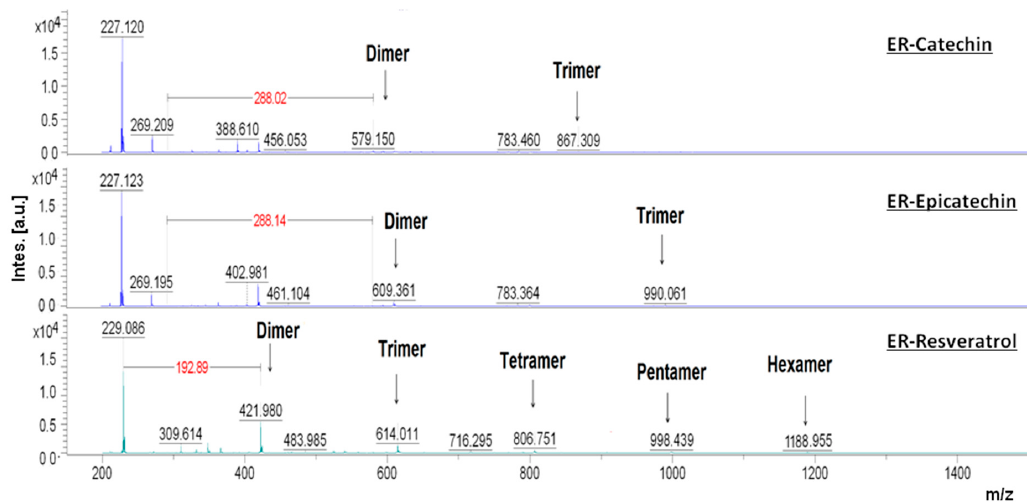
Figure 2. Molecular weight distribution in the enzymatic reaction (ER) with catechin, epicatechin and resveratrol. Mass spectra obtained through Matrix-Assisted Laser Desorption/Ionization Mass Spectrometry (MALDI-TOF-MS) with amplification from 150 to 1500 m/z . The samples were obtained from the ER medium after 30 min from the start of the reaction. The concentrations of phenolic compounds (PCs), peroxidase, and hydrogen peroxide (H 2 O 2 ) in the reaction medium of the ER were 1.5 mM, 2.5 U/mL, and 0.05%, respectively.